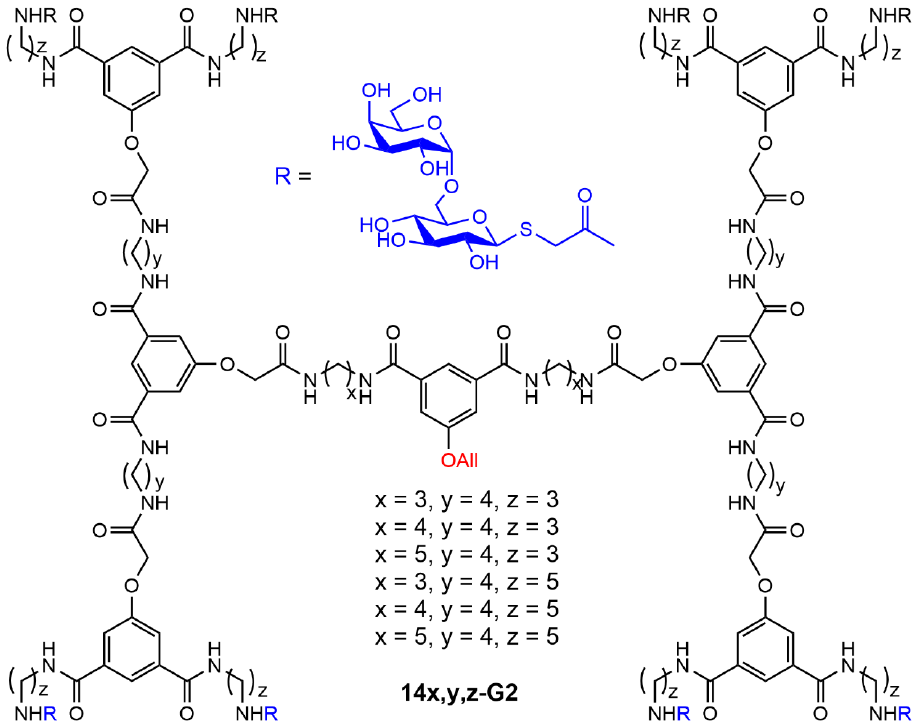
Figure 11. Structure of a large family of glycodendrons obtained by a parallel combinatorial approach and suitable for producing hydrogels at low concentration.